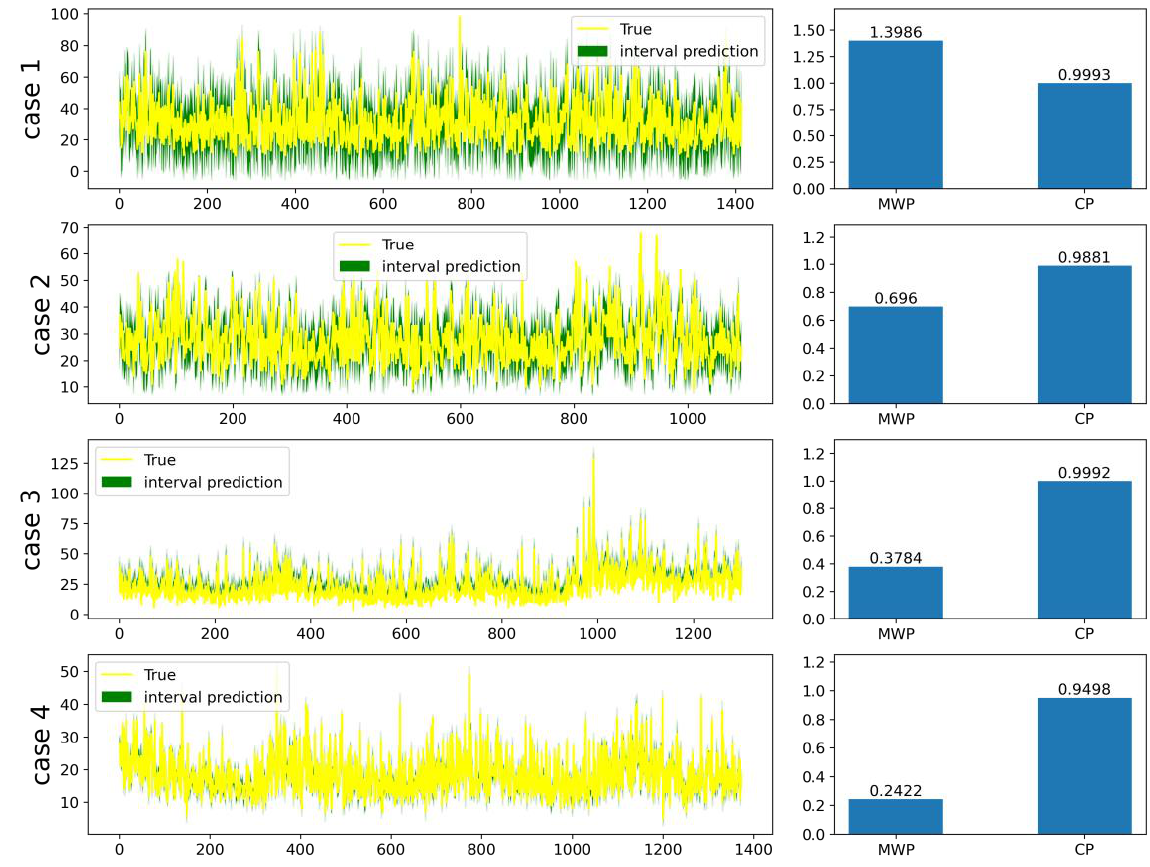
Figure 19. The interval prediction estimate of four cases. Table 7. Parameters of cases used in GP.